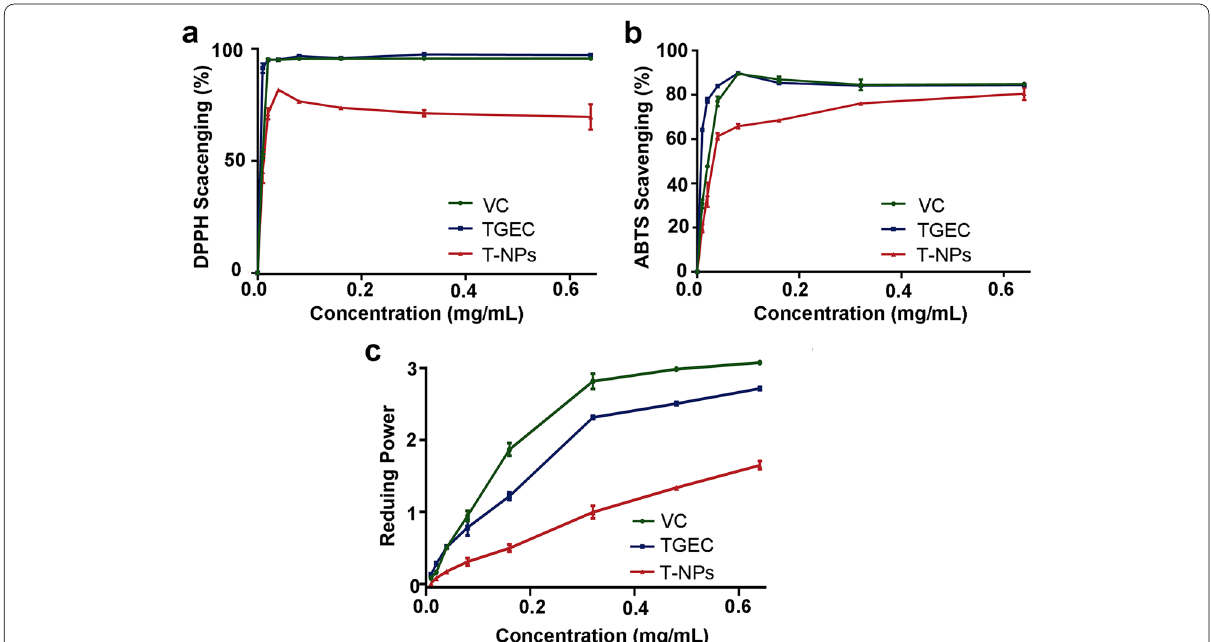
Fig. 5 Anti-oxidation capacity of T-NPs. a DPPH radical scavenging activity of T-NPs. b ABTS radical scavenging activity of T-NPs. c Reducing power of